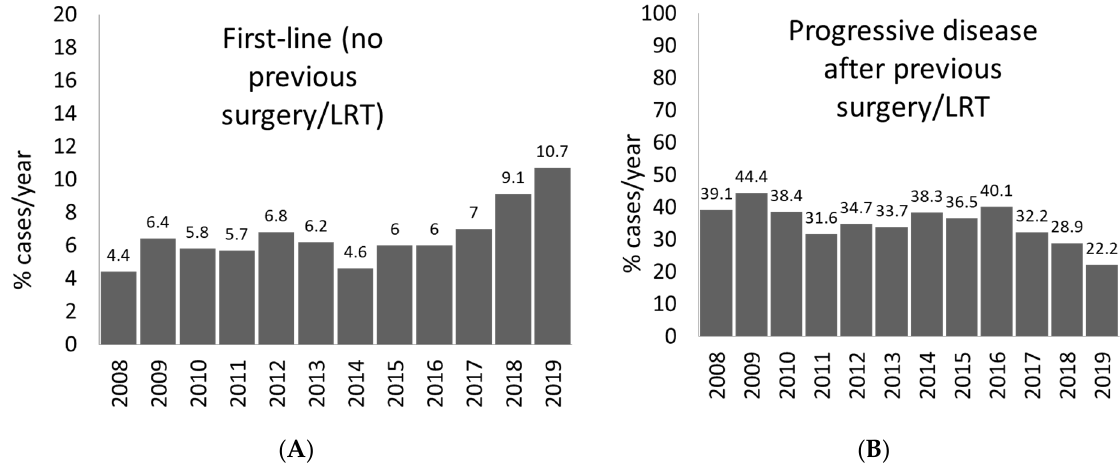
Figure 3. ( A , B ) Proportion of patients with new onset HCC or with HCC recurrence after surgery or locoregional treatment, which is amenable to first-line treatment with atezolizumab plus bevacizumab, per year, in the ITA.LI.CA database.